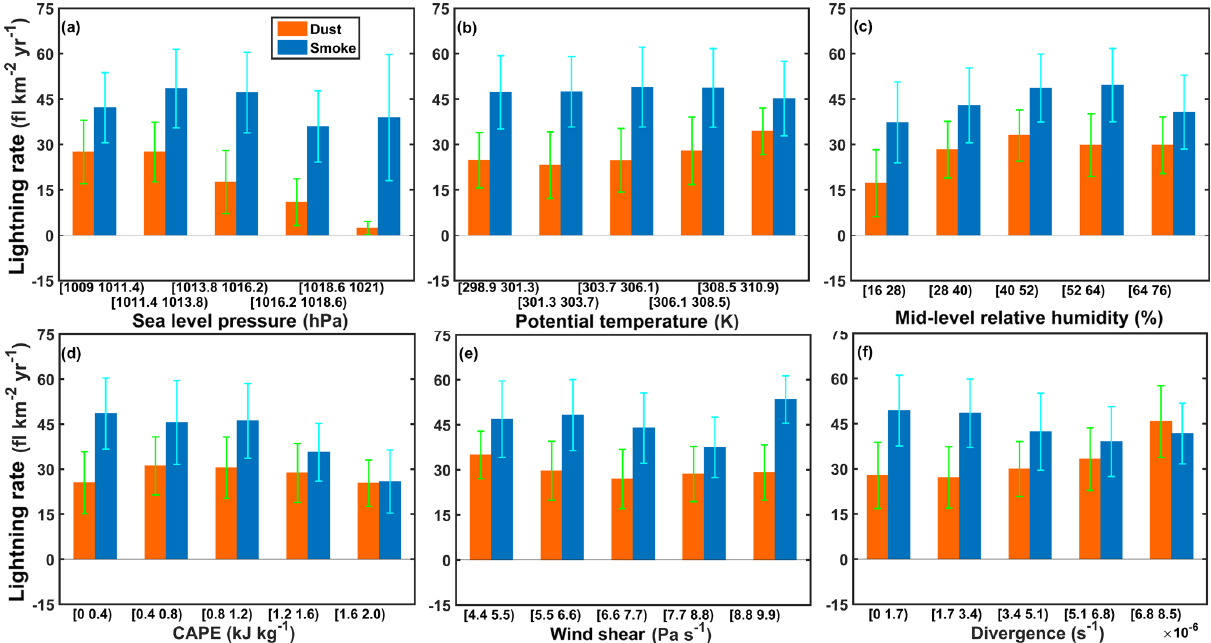
Figure 11. Differences (polluted minus clean subsets of data) in lightning flash rate as a function of (a) sea level pressure, (b) potential temperature, (c) mid-level relative humidity, (d) convective available potential energy (CAPE), (e) vertical wind shear, and (f) 200hPa divergence in the dust- (in orange) and smoke-dominant regions (in blue). Note that the top third of aerosol optical depth (AOD) values (AOD ∈ (0, 1)) is labeled as polluted, and the bottom third is labeled as clean. Vertical error bars represent 1 standard